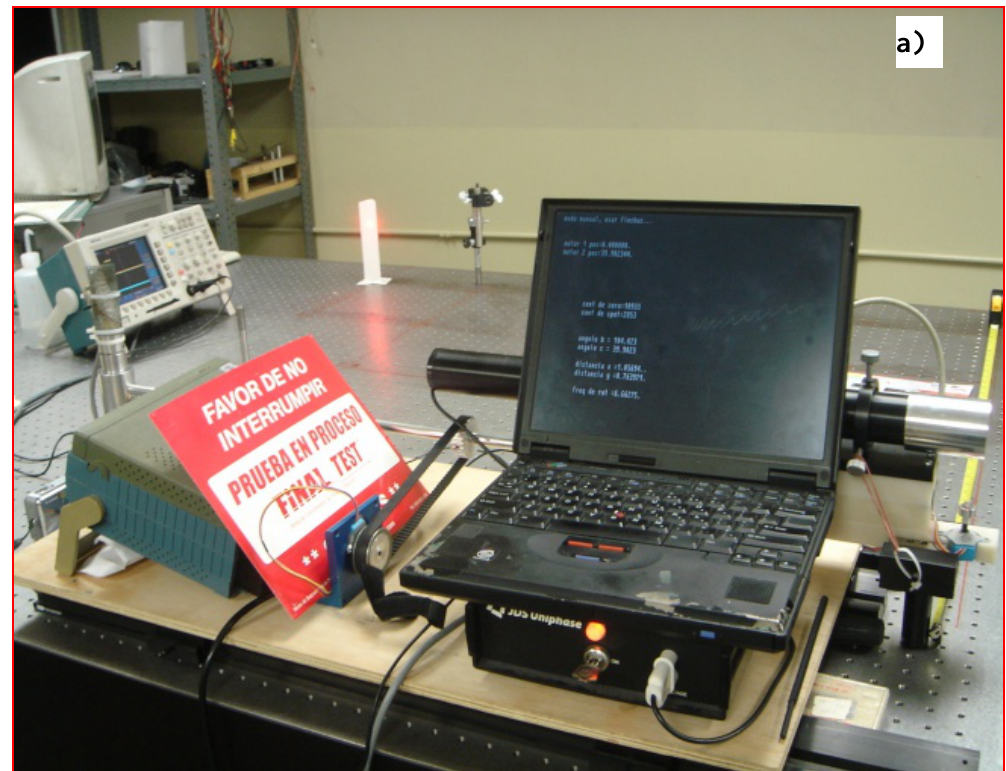
Figure 6. Experiments using laser spot: a) on obstacle variable position. b) in order to determine coordinates ( x,y